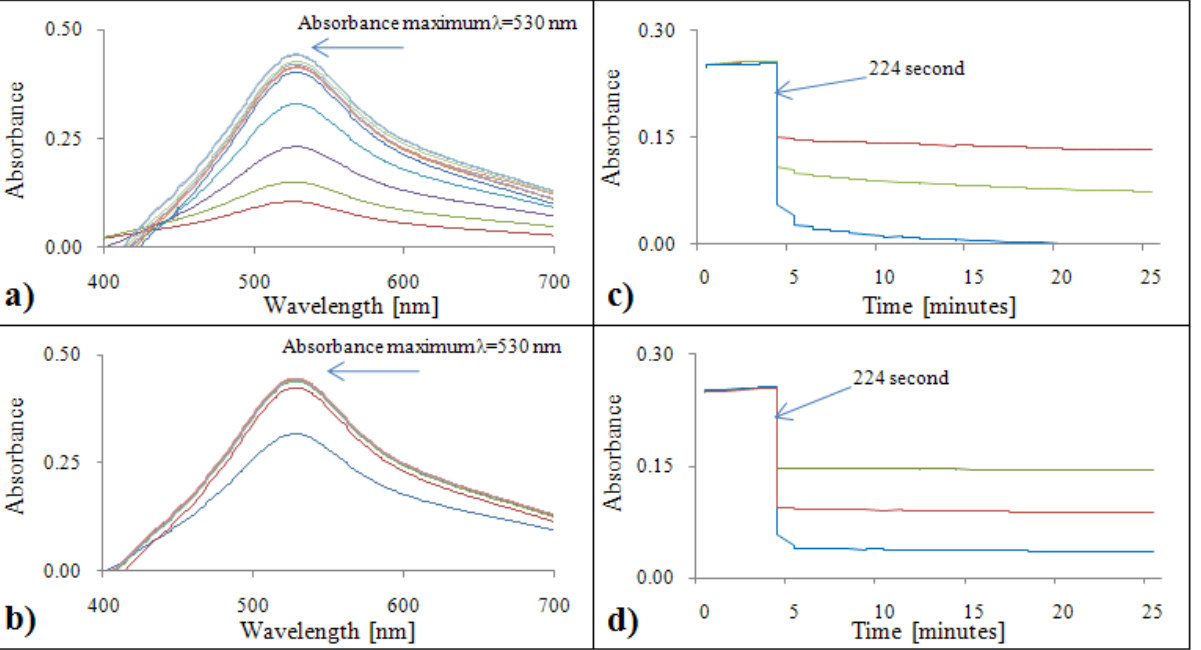
Figure 1. DPPH absorption spectra (400 – 700 nm) for gallic acid (a) and Trolox ® (b) . Dependence of absorbance of DPPH radical with gallic acid (c) and Trolox ® (d) on